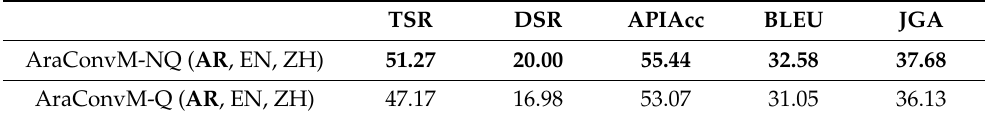
Table 6. Multi-lingual experiment DST and end-to-end dialogue generation results for the AraConv model on the Arabic-TOD dataset. The bold letters refer to the target language. Bold numbers indicating the best result according to the column’s metric